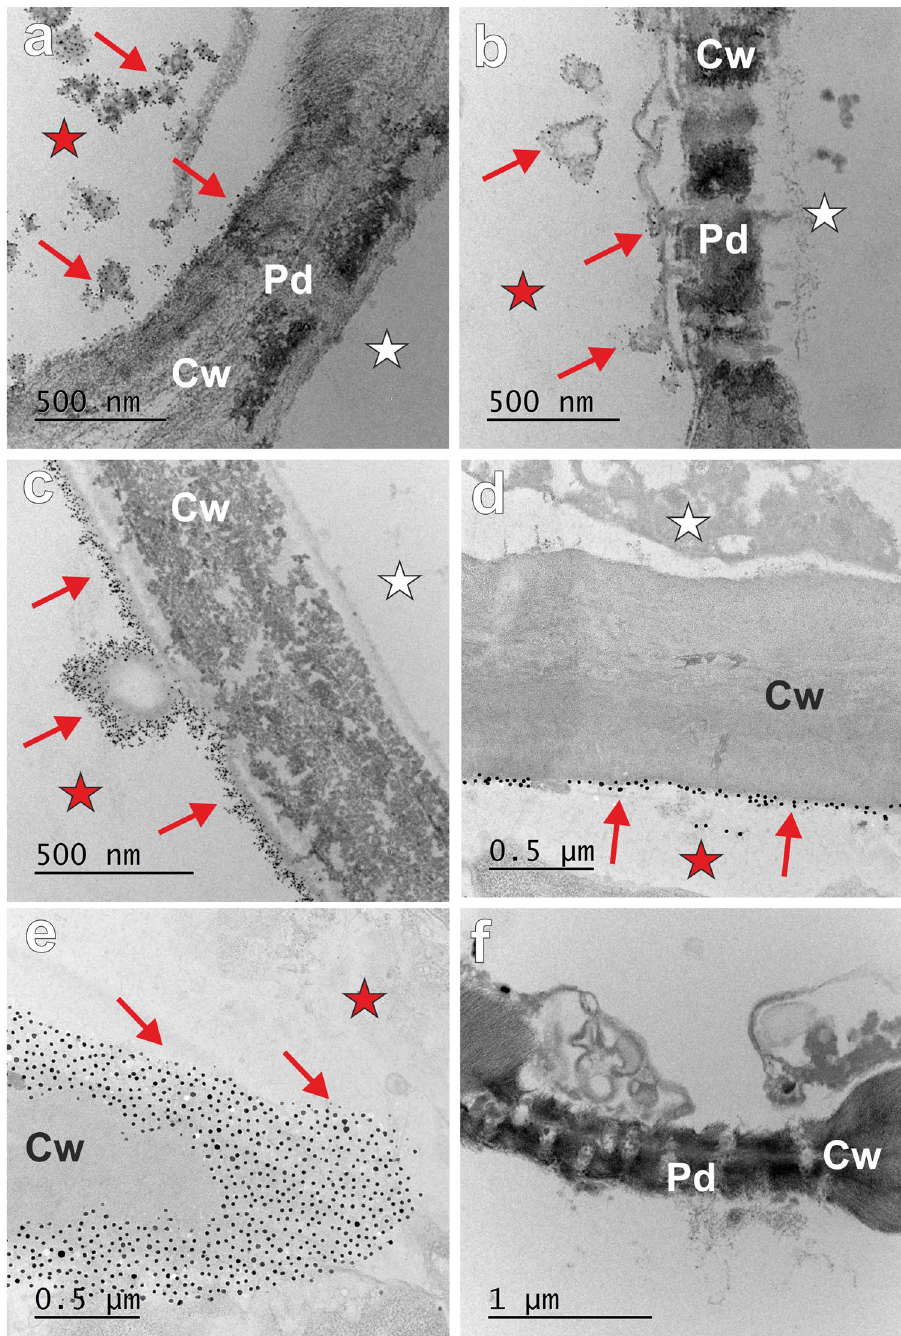
Figure 5. Representative ultrastructure of the barley root cells that had been incubated with DDG and treated with nanogold that was applied directly to the cell. ( a – c ) Roots treated with 5 nm AuNPs. ( d–f ) Roots treated with 20 nm AuNPs. Red arrows indicate the presence of AuNPs in punctured cells (red asterisks); white asterisks indicate unwounded cells adjacent to the punctured cells where AuNPs were not present. Cw – cell wall, Pd –